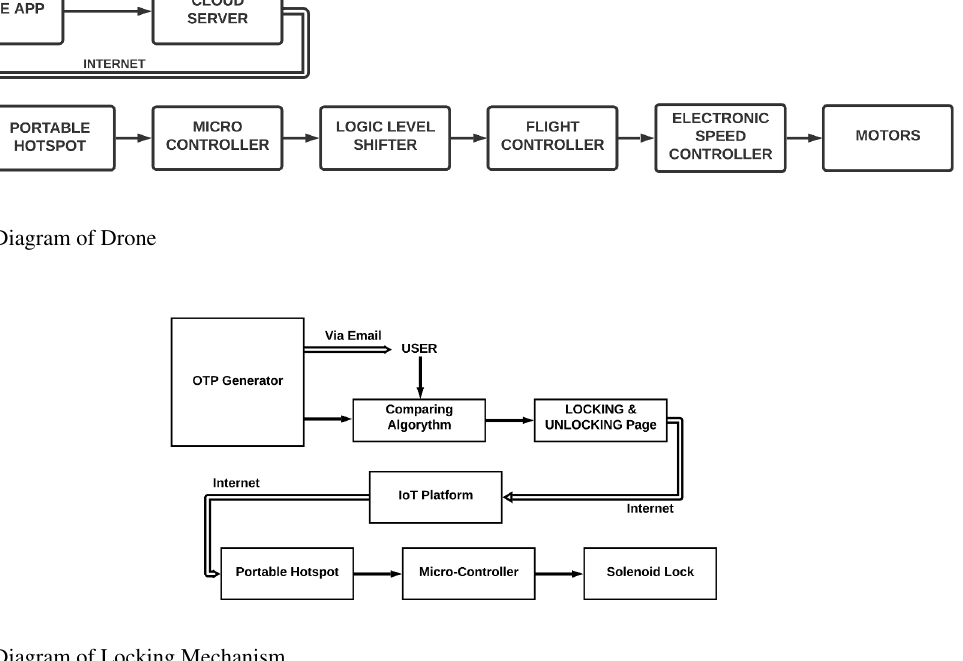
Figure 2. Block Diagram of Locking